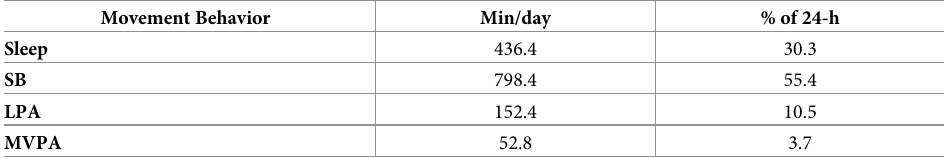
Table 2. Geometric means for movement behaviors.